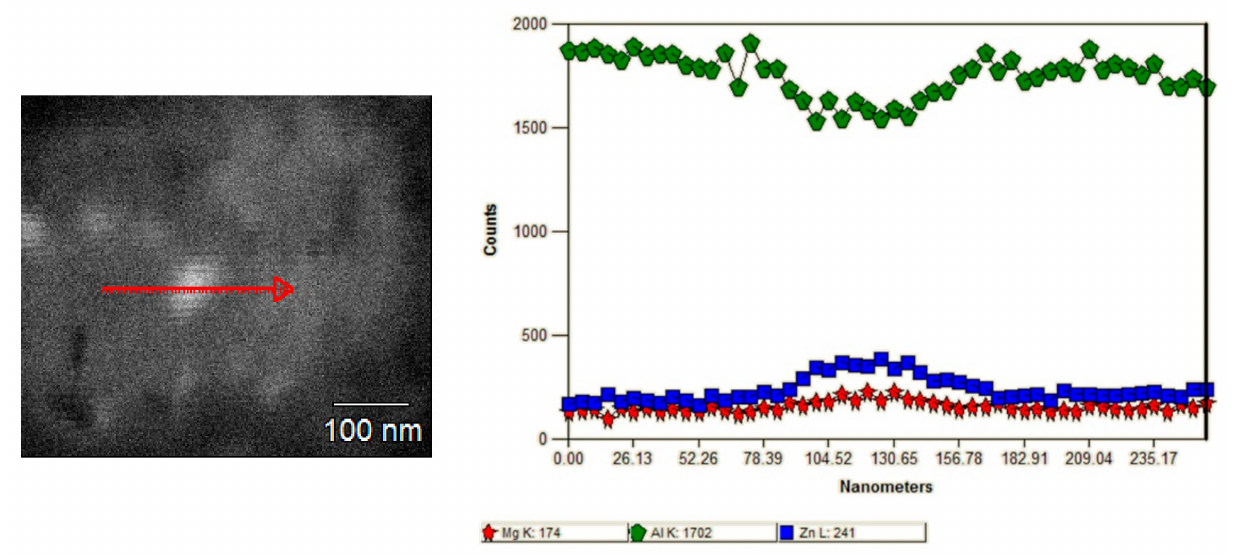
Figure 6. SEM/EDS analysis of the second-phase